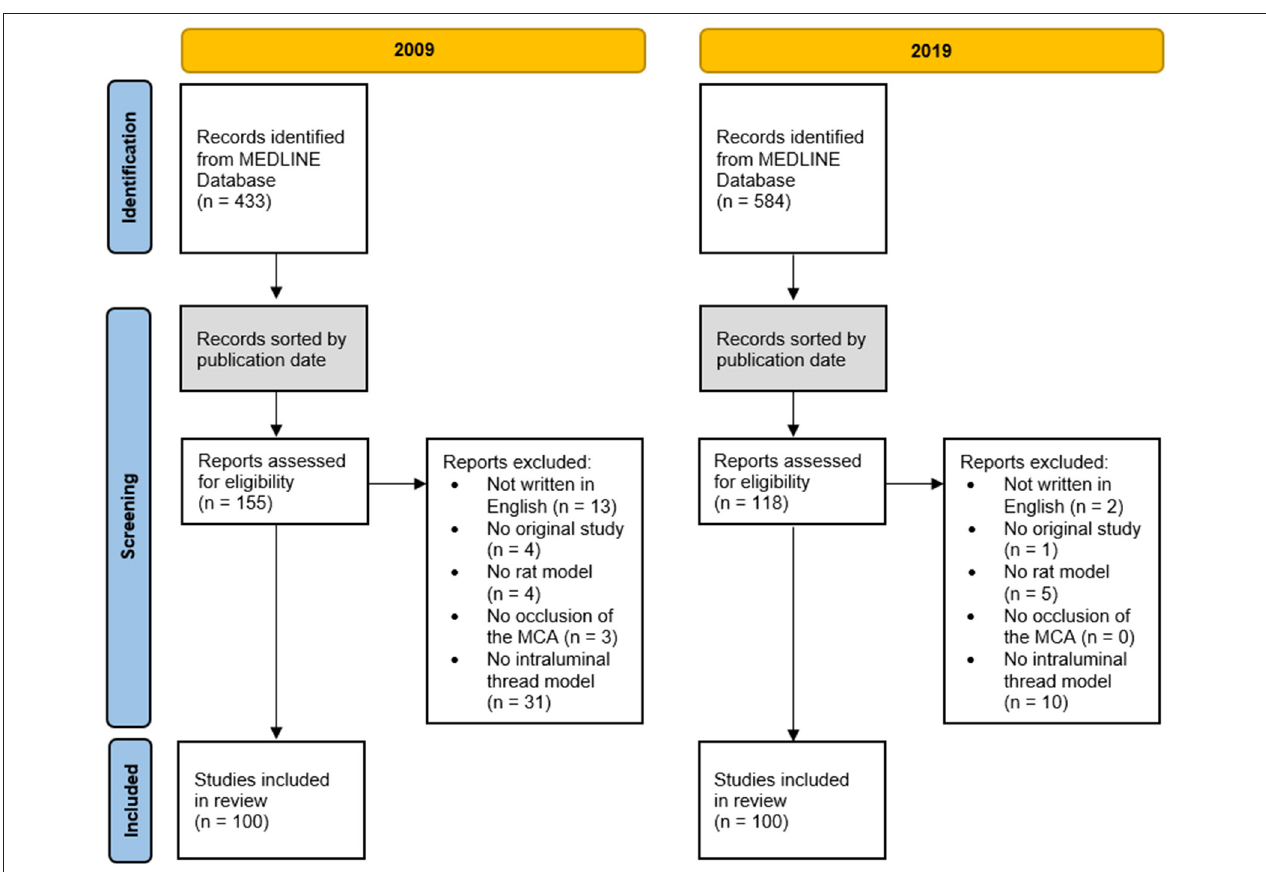
FIGURE 1 | Flow of database search, screening, eligibility, selection, and inclusion of